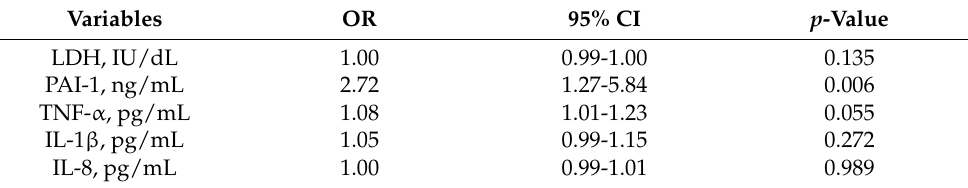
Table 2. Multivariate logistic regression analyses of variables related to RPT > 10 mm among